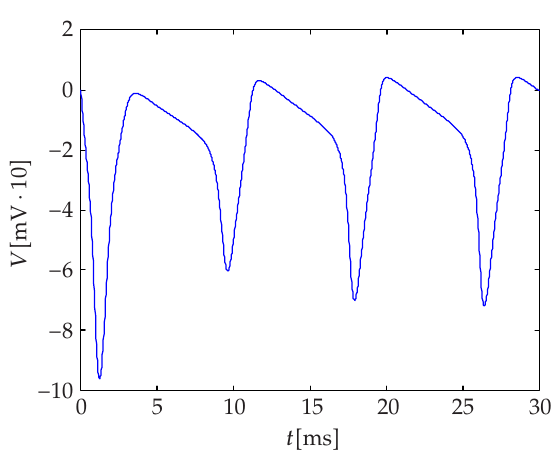
Figure 1.1 . Action potential obtained from HHCC model in the in- terval t ∈ ( 0 , 30 )